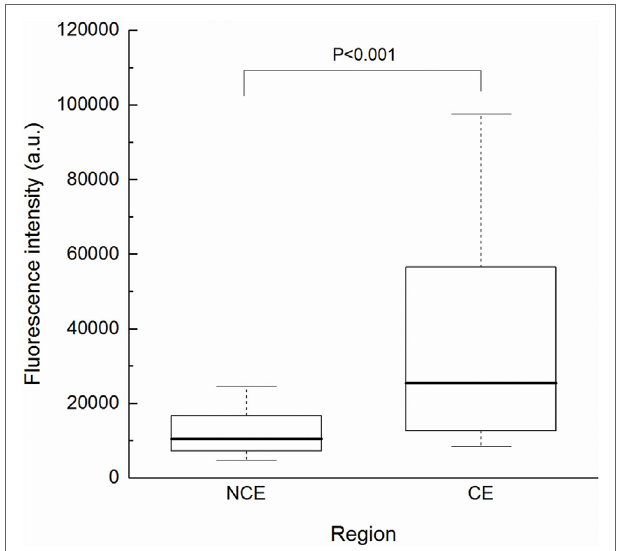
FigUre 5 | Fluorescence intensity of samples from the CE region of newly diagnosed ( n = 11) and recurrent ( n = 30) cases. There was no significant difference between the two groups (Mann–Whitney U test, P = 0.26). Each box indicated the interquartile range, and the median was shown with a bold line. The ends of the whiskers represented the 10th and the 90th percentile. CE, contrast-enhanced.